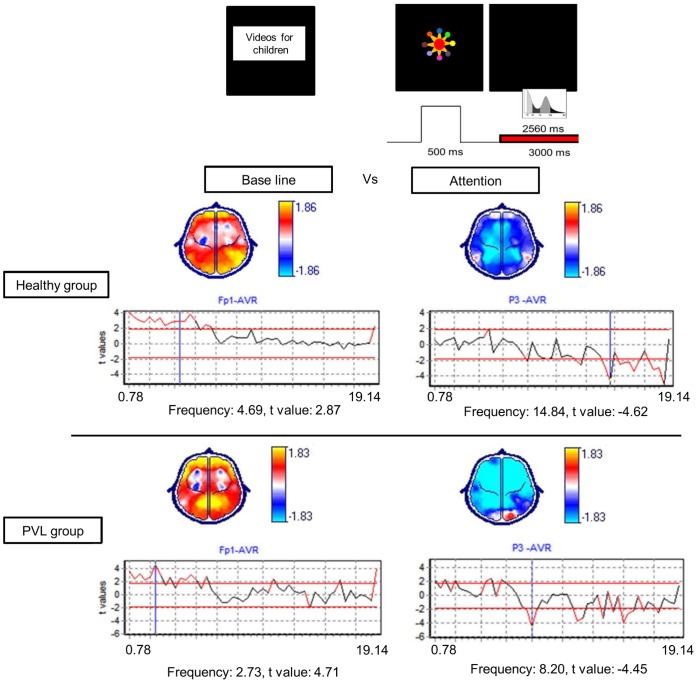
Post-hoc t-test comparing the differences between the baseline and attention conditions in each group.Positive t values, shown in yellow on the topographic map, imply power increases during the attention condition compared to baseline. Negative t values, shown in blue on the topographic map, imply power decreases during the attention condition compared to the baseline.